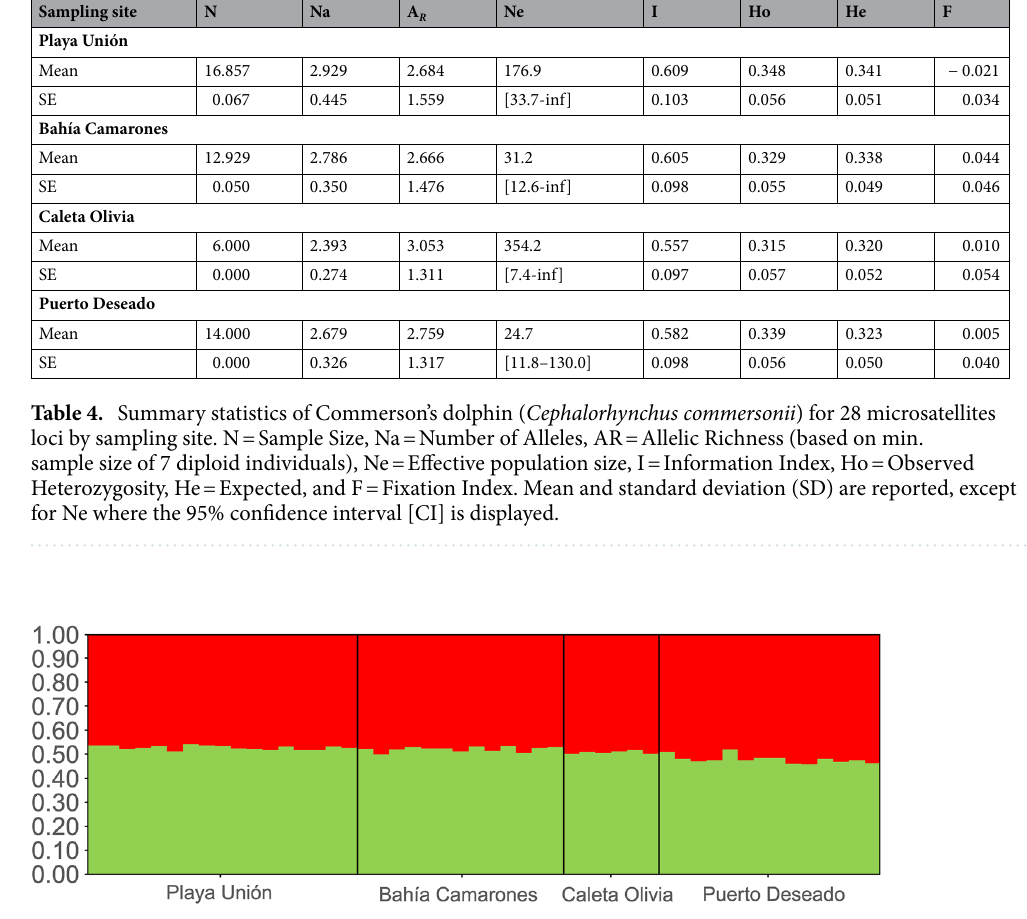
Figure 4. Hierarchical STRU CTU RE analysis of Commerson’s dolphin ( Cephalorhynchus commersonii ) from the four sampling regions based on 28 microsatellite loci and 50 individuals. Each individual is represented by a vertical line, which is partitioned into K colored segments, where each colored segment length is proportional to the individual’s estimate membership